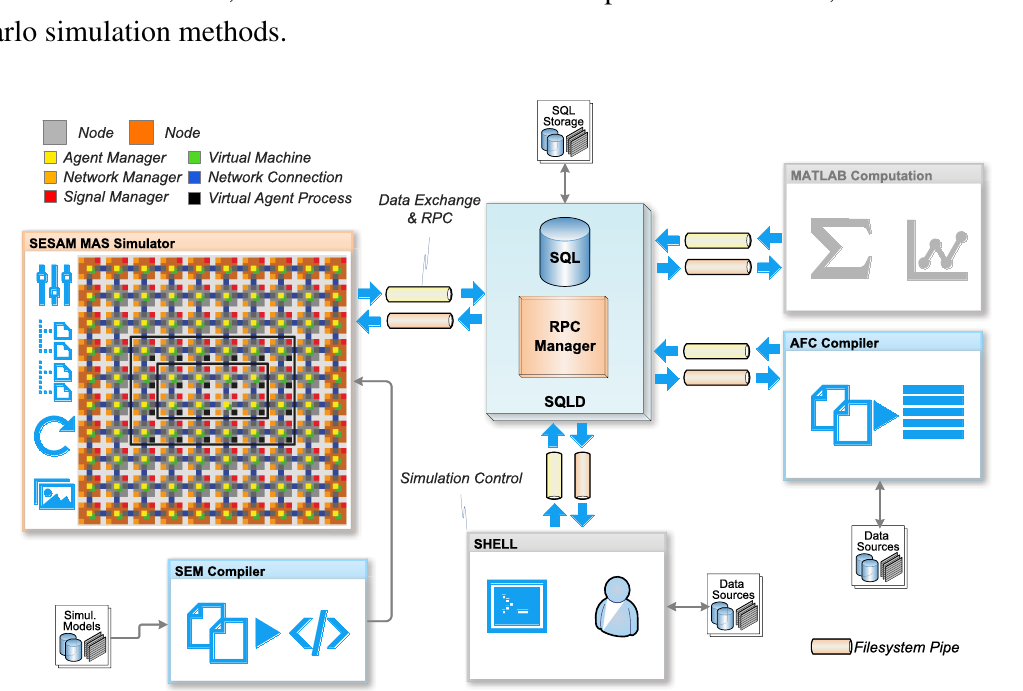
Figure 8. ( Left ) Simulation environment with the simulation world of a sensor network with sensor nodes containing the PAVMprocessing platform (with multiple VM and manager components, each simulated using an agent); ( Right ) The simulator operates on a database for storing output and reading input data (e.g., the program